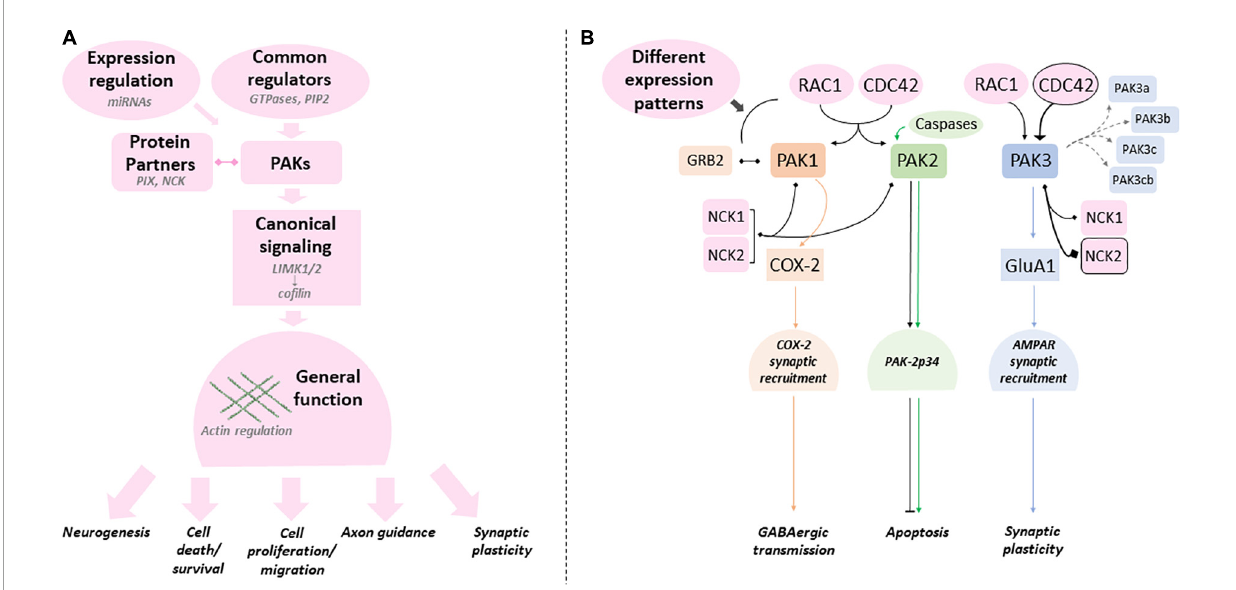
FIGURE6 Canonical and specific PAK-dependent processes (A) Group I PAKs share several regulatory mechanisms, protein partners and substrates (canonical processes in pink - examples in light gray). PAK mutations can affect any of these processes. (B) Several studies emphasize the differences between PAKs (canonical processes in pink can still present quantitative differences). PAKl (orange), PAK2 (green) and PAK3 (blue) were shown to have their own specificities (colors matching the corresponding PAK). Protein partners and regulators that are favored by PAK are emphasized with a black frame. Mutations can have different effects on these specific processes and explain the variations found between PAKs and intragenic